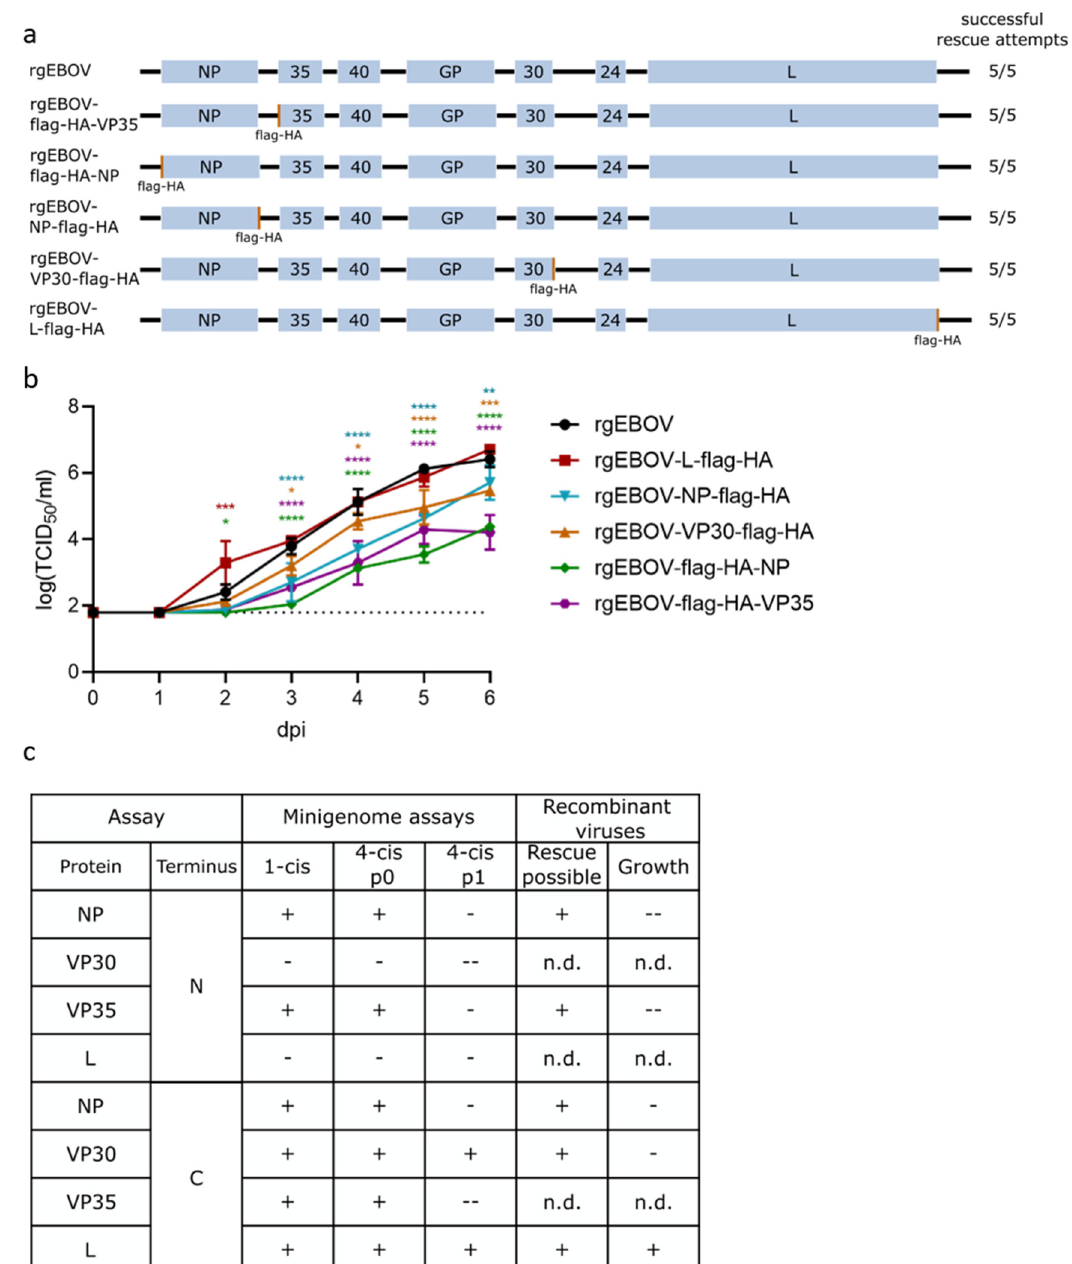
Figure 2. Rescue and characterization of recombinant EBOVs encoding flag-HA-tagged proteins. ( a ) Genome structure of rescued recombinant viruses and rescue efficiency. ( b ) Growth kinetic of res- cued viruses. VeroE6 cells were infected with 1 × 10 4 TCID 50 of recombinant EBOV with flag-HA- tags at the N- or C-terminus (as noted) of the RNP protein or wild type virus (rgEBOV). Supernatant was harvested at indicated time points and titrated on VeroE6 cells to determine the viral titer. The lower limit of detection is indicated by a dotted line. Means and standard deviations of three bio- logical replicates are shown. Significant differences compared to wt are indicated: n.s.: not signifi- cant; *: p < 0.5; **: p < 0.01; ***: p < 0.001; ****: p < 0.0001. ( c ) Summary of minigenome (from Figure 1) and virus data for comparison. Symbols indicate whether results were comparable to the positive control or wild type (+; no significant reduction in reporter activity or mean reduction in titers in growth kinetics), slightly reduced (-; significant but less than 1 log reduction in reporter activity or mean reduction in titers in growth kinetics), or highly reduced (--; more than 1 log reduction in reporter activity or mean reduction in titers in growth kinetics). n.d.: not done.